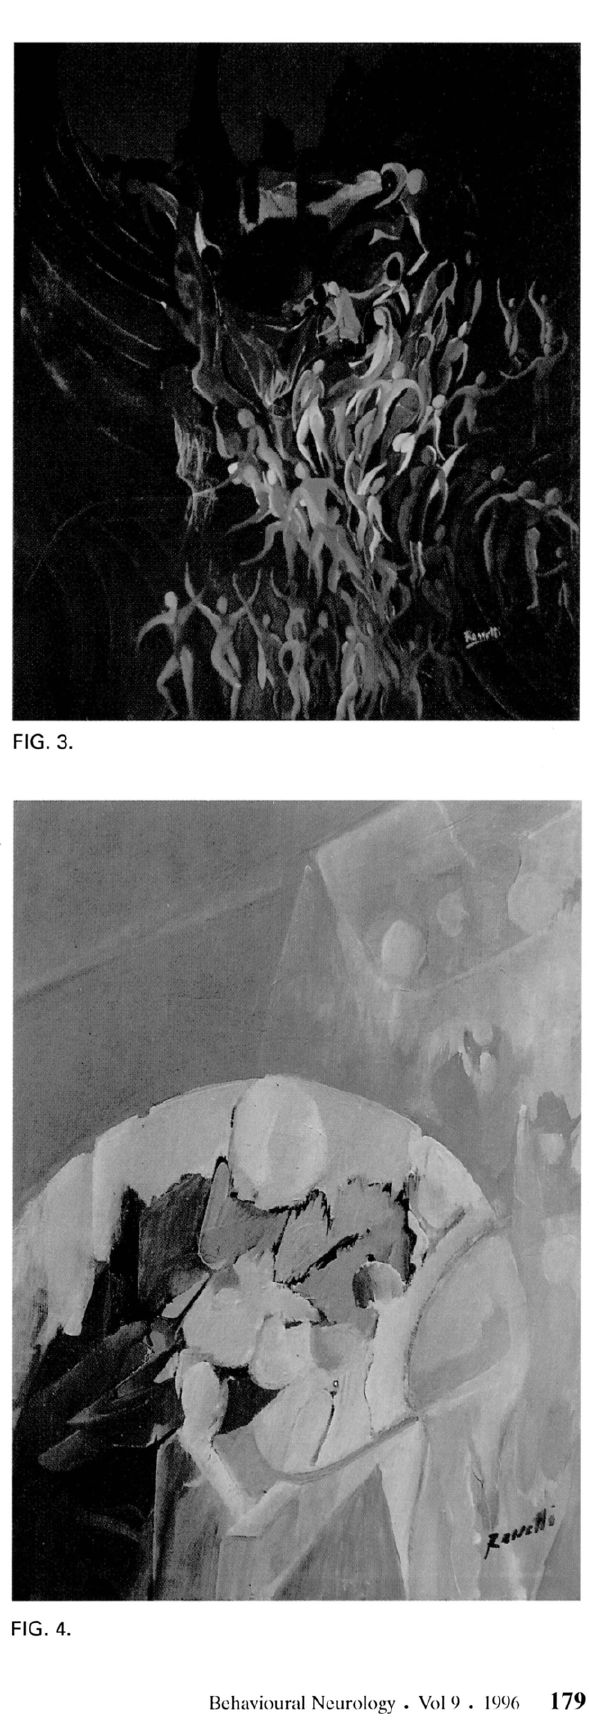
Behavioural Neurology. VollJ • I